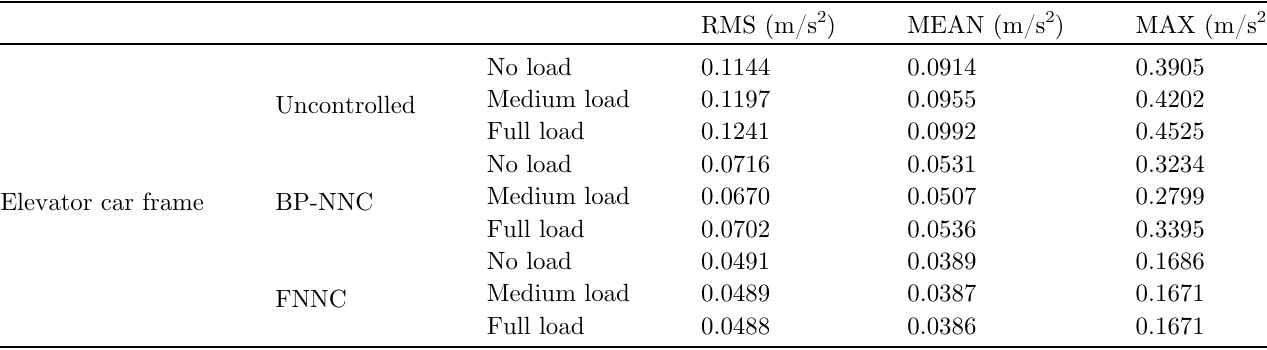
Table 5. Time-domain response results of horizontal vibration acceleration of the elevator car